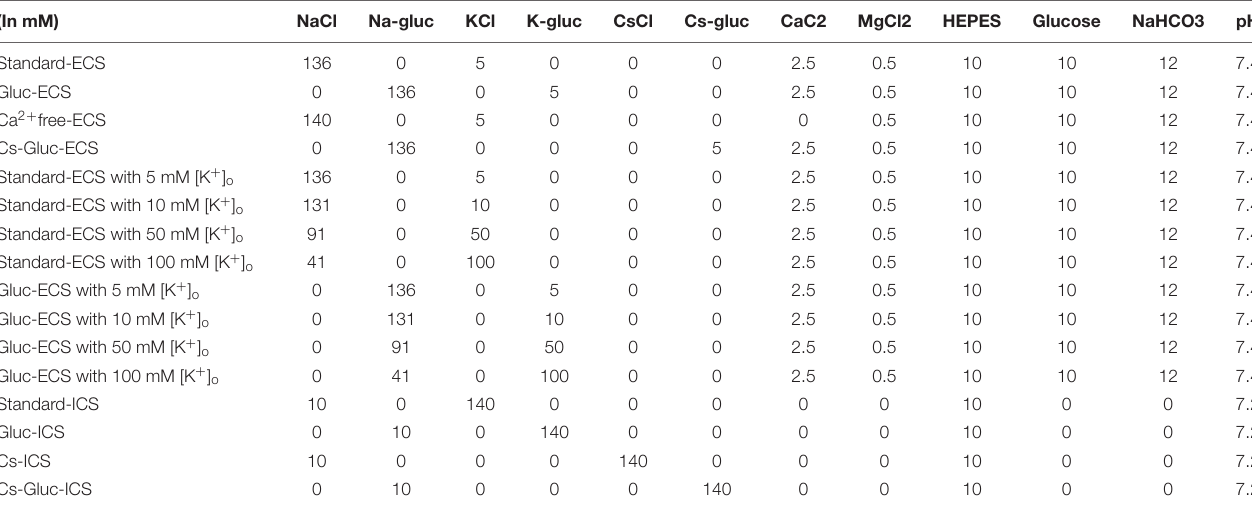
TABLE 1 | Composition of extracellular and intracellular solution. (In